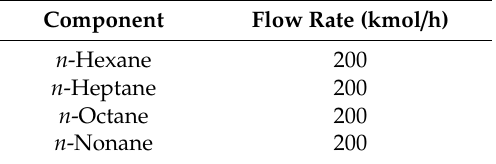
Table 5. The original inflow of the four-component alkane case. Component